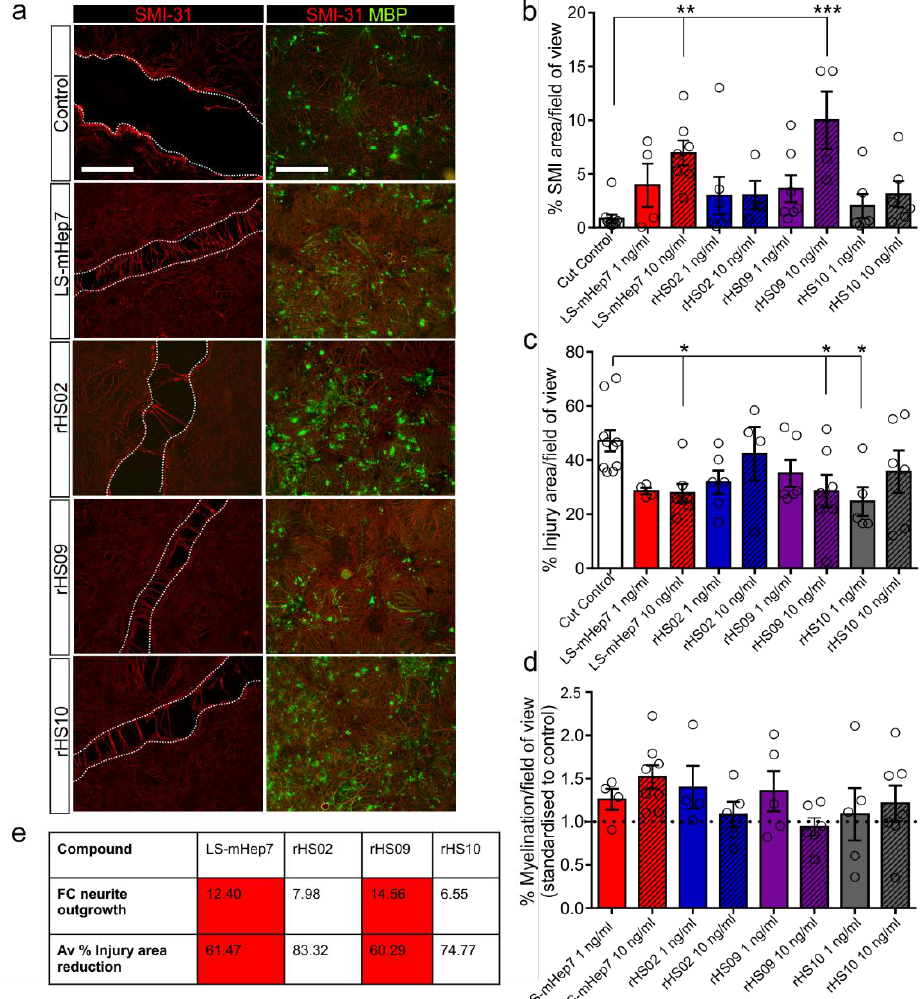
Figure 3. Effect of LS-mHep7, rHS02, rHS09 and rHS10 on neurite outgrowth and myelination after injury. Myelinating cultures at 24 DIV were injured by cutting with a scalpel blade (termed MC-Inj after injury). Cultures were immediately treated with LS-mHep7, rHS02, rHS09 or rHS10 at 1 or 10 ng/mL or left untreated as control. 5 DIV post treatment, cultures were fixed and stained to assess both neurite outgrowth across the lesion, gap width or myelination adjacent to the lesion. ( a ) Representative images of control cut, or myelination adjacent to the lesion. LS-mHep7, rHS02, rHS09 and rHS10 at 10 ng/mL. SMI-31 stains axons in red and MBP stains myelin in green. Dotted line demarcates injury site. Scale bar represents 50 µ m. ( b ) Graph shows quantification of % axonal outgrowth in the injury region of interest (ROI). Both LS-mHep7 and rHS09 at 10 ng/mL significantly promoted neurite outgrowth across the lesion compared to control cultures. ( c ) Quantification of injury gap width. ( d ) Quantification of % myelination adjacent to the lesion. ( e ) Table details the average FC in neurite outgrowth and the average % reduction in injury gap width compared to tied cut control cultures. Red highlights similarity in FC differences between LS-mHep7 and rHS09 ( n number represented by individual circle data points on graph, ANOVA with Dunnett’s post -test, * p < 0.05, ** p < 0.01, *** p < 0.001).